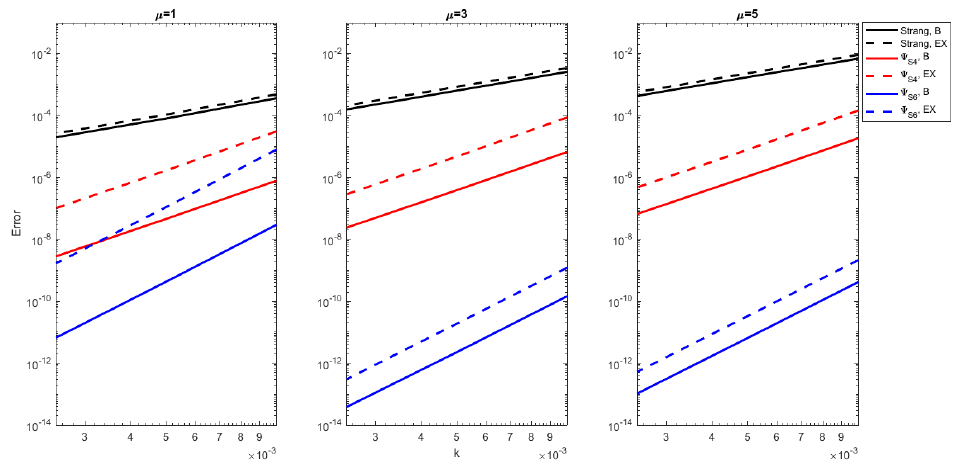
Figure 1. Error, in logarithmic scale, for the energy norm of the solution of Test 1, with µ = 1, µ = 3 and µ = 5, N = 100, final time T = 1 and EX ( f ) , for Strang’s method (black), Ψ S 4 (red) and Ψ S 6 (blue).